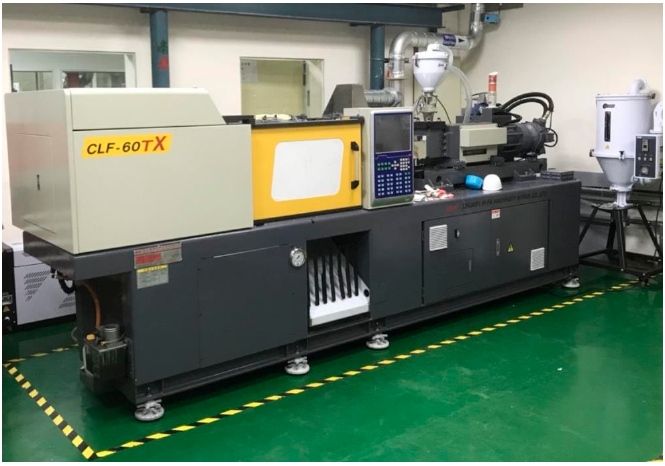
Figure 1. CLF 600TX Plastic Injection Molding Machine.